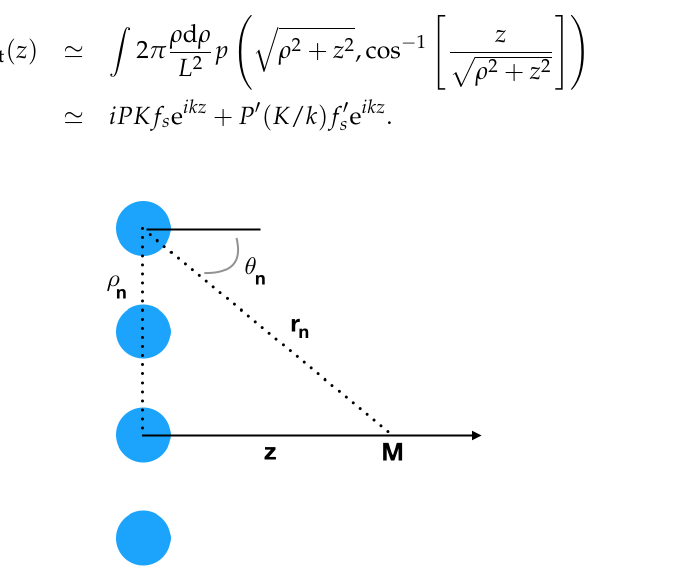
Figure A1. The pressure field generated by scatterer n at Point M is given by Equation